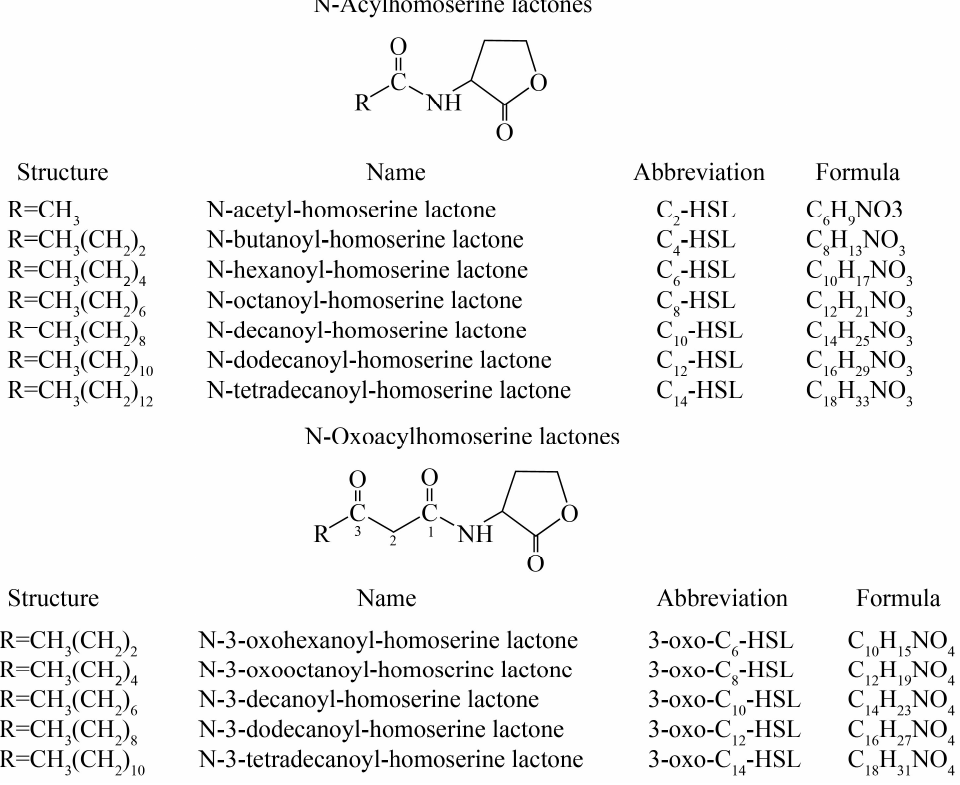
Figure 2. Structures, names, abbreviations, and formulas of the 12 quorum-sensing system AHLs. Molecules 2019 , xx , x FOR PEER REVIEW 5 of 11